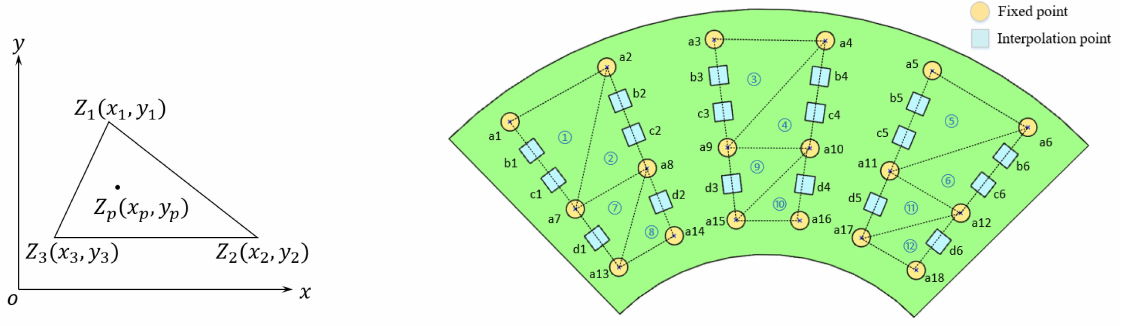
Figure 5. Schematic diagram of planar data interpolation. Note the numbers in circles mark the triangles for interpolation operations, treating the fixed points as